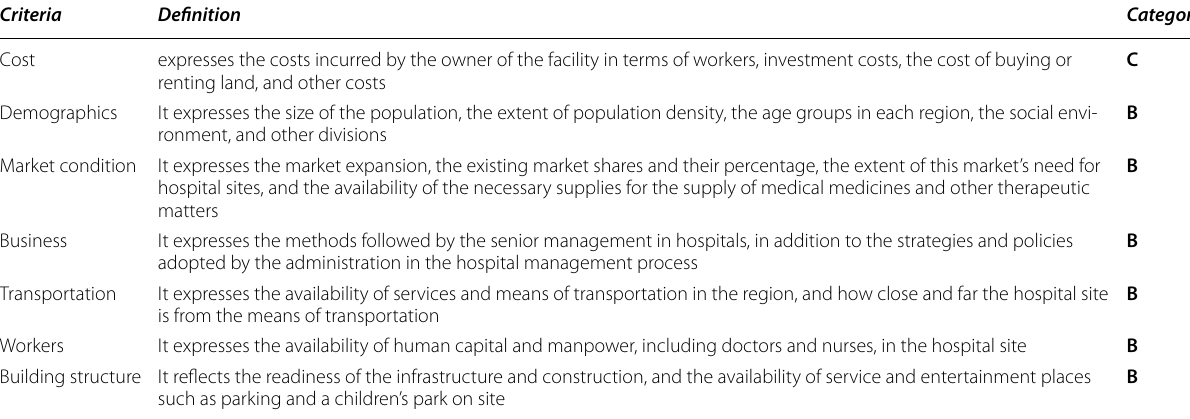
Table 4 Criteria for evaluation of hospital location selection